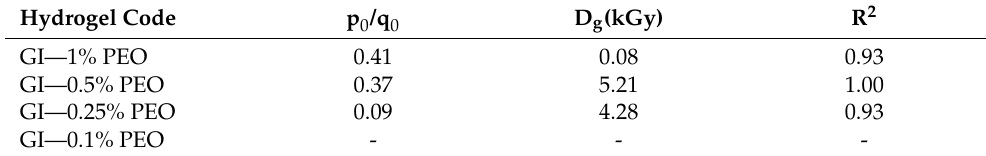
Table 1. Sol-gel analysis for hydrogels with different concentrations of PEO.